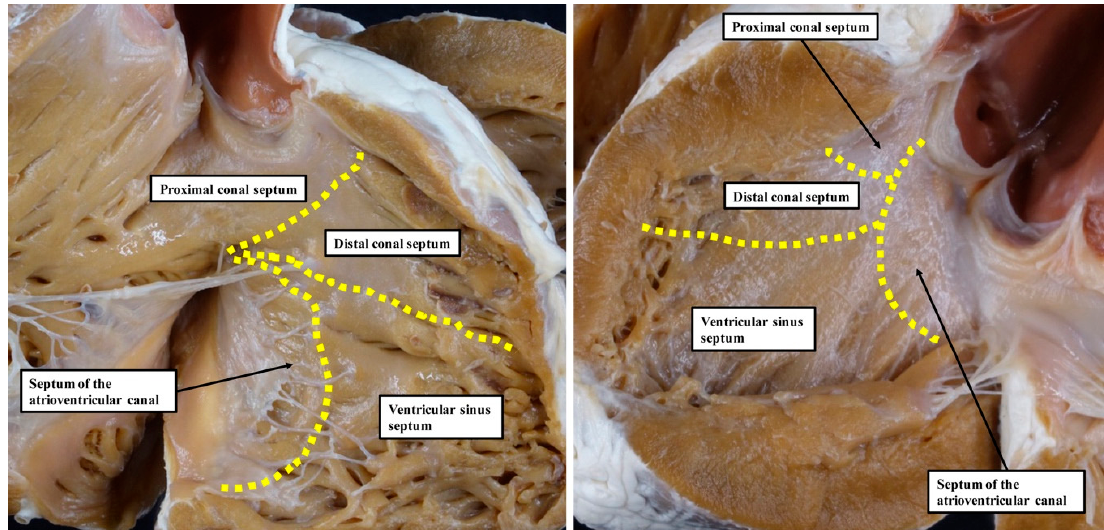
Figure 1. These images, of a normal heart held in the pathological archive of Cincinnati Children’s Hospital, show the suggested division of the definitive ventricular septum based on the presumptive development as described by Van Praagh and his colleagues [5]. The left -hand panel shows the view of the opened right ventricle with the lines superimposed as described by Van Praagh and his associates. The right -hand panel shows the view from the left ventricle.